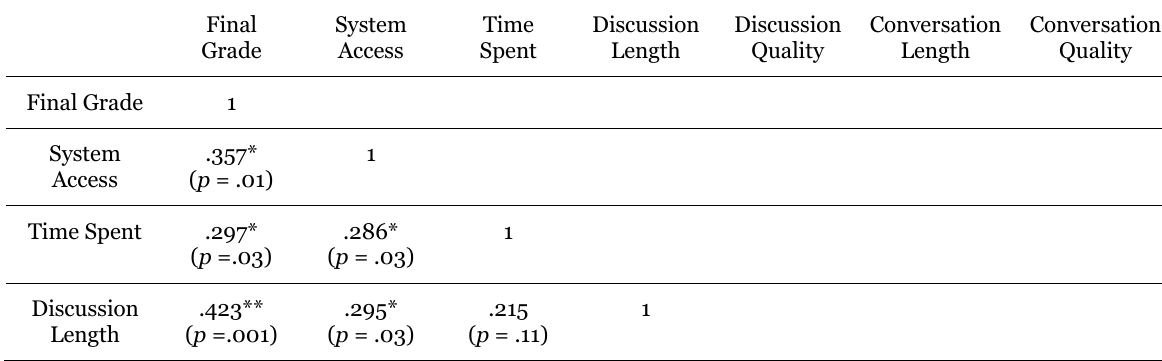
Correlation of Learner Participation in Online Courses and Conversational Activity (N =